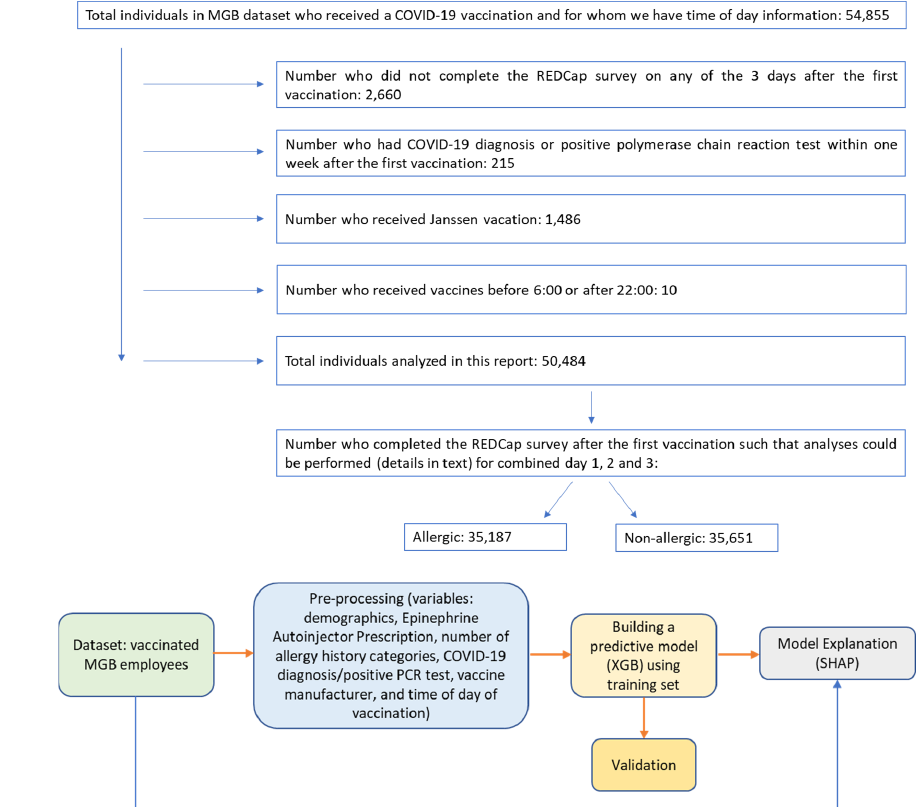
Figure 1. ( A ): Creation of dataset; ( B ): Block diagram illustrating the processing stages used in this study to identify predictors of post COVID-19 vaccine-related side effects.